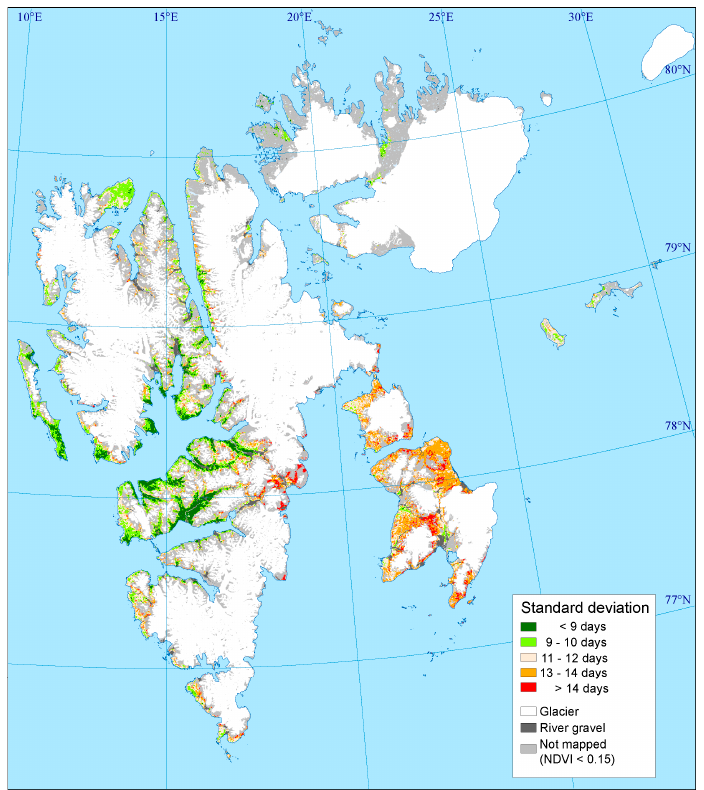
Figure 6. Standard deviation in onset of vegetation growth for the 2000–2020 period.